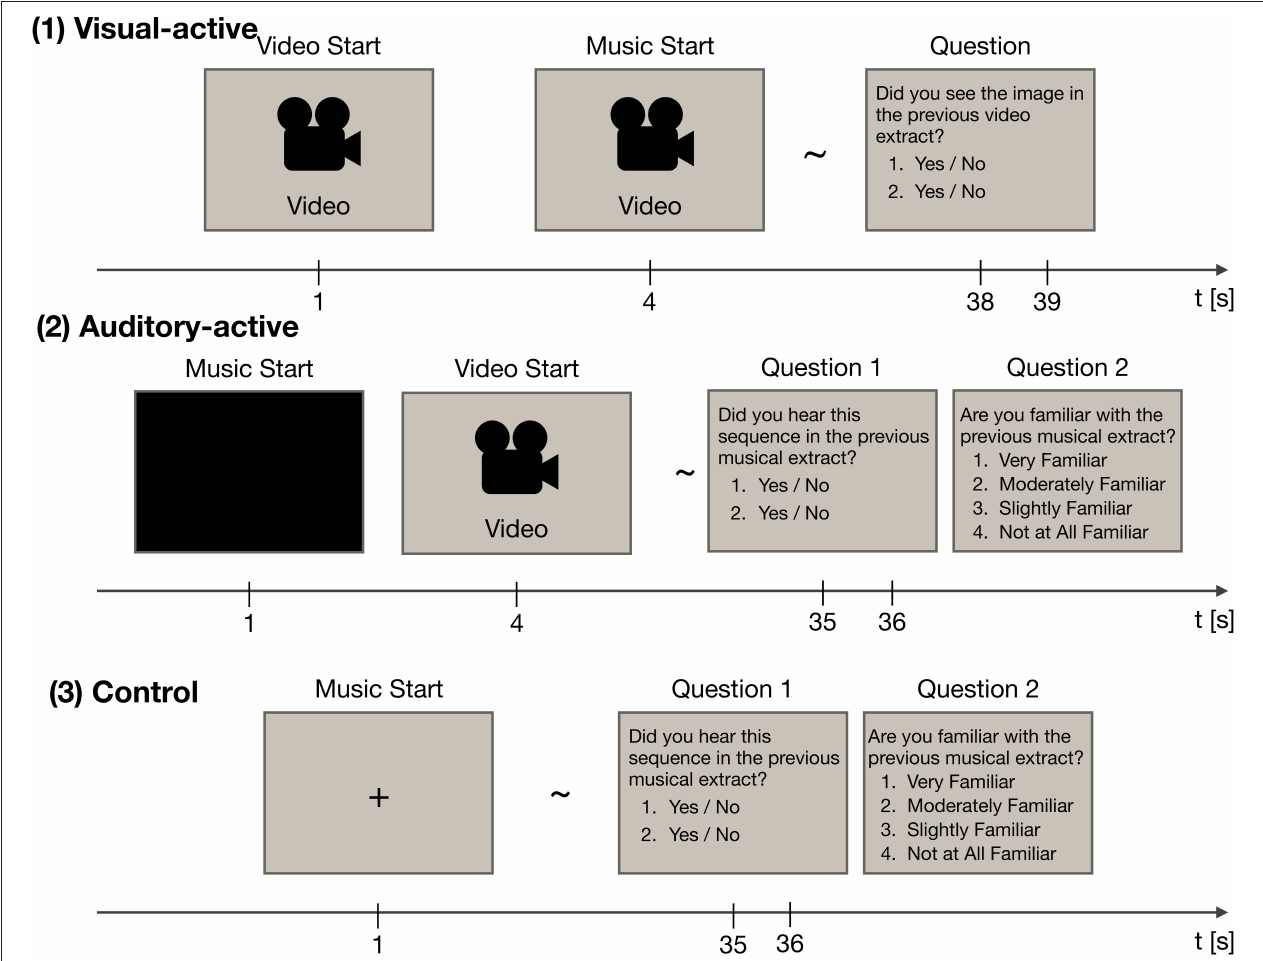
FIGURE 1 | The experimental paradigm, consisting of three tasks: visual-active, auditory-active, and control. Each task was divided into thirty trials. In each trial, EEG recordings were acquired. Each of the thirty trials employed a different stimulus at